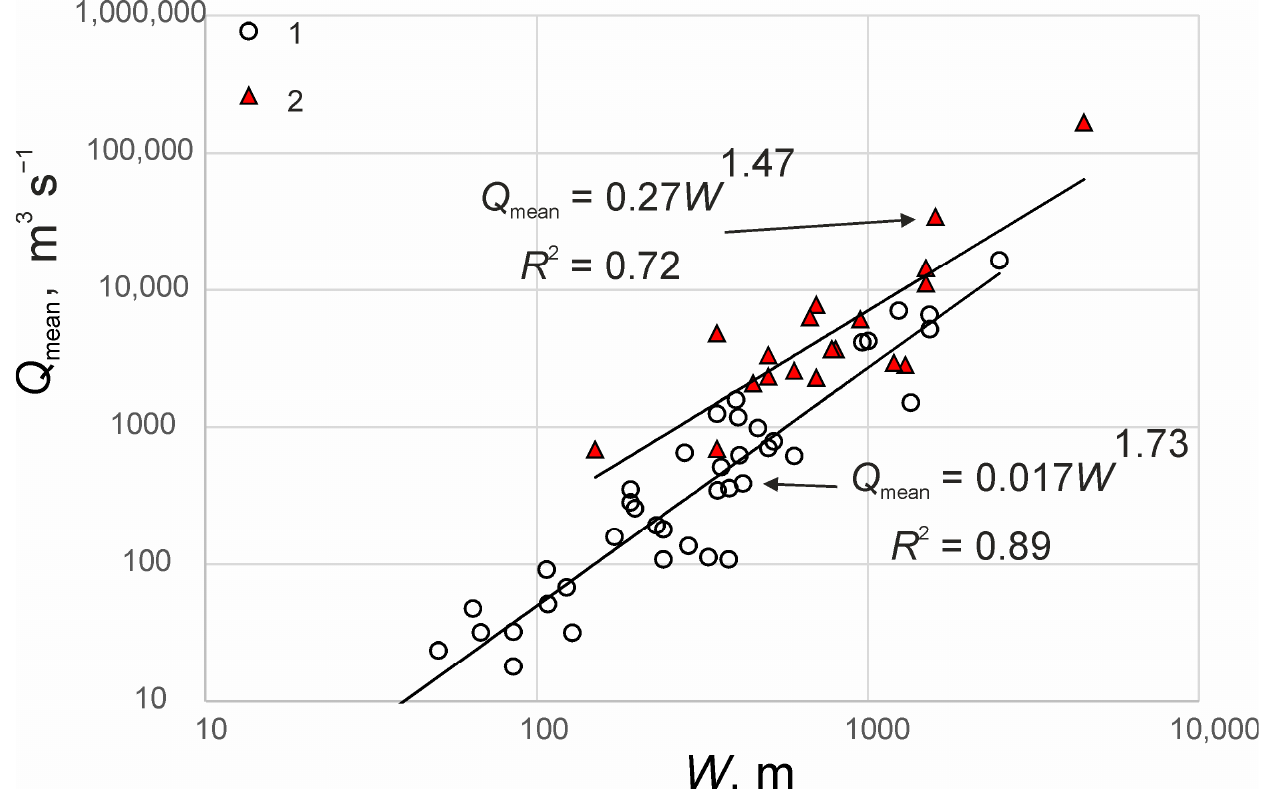
Figure 7. Relationship between bankfull width W and mean annual discharge Q mean for the rivers of the Lena River basin (1) and the Amazon River basin (2).